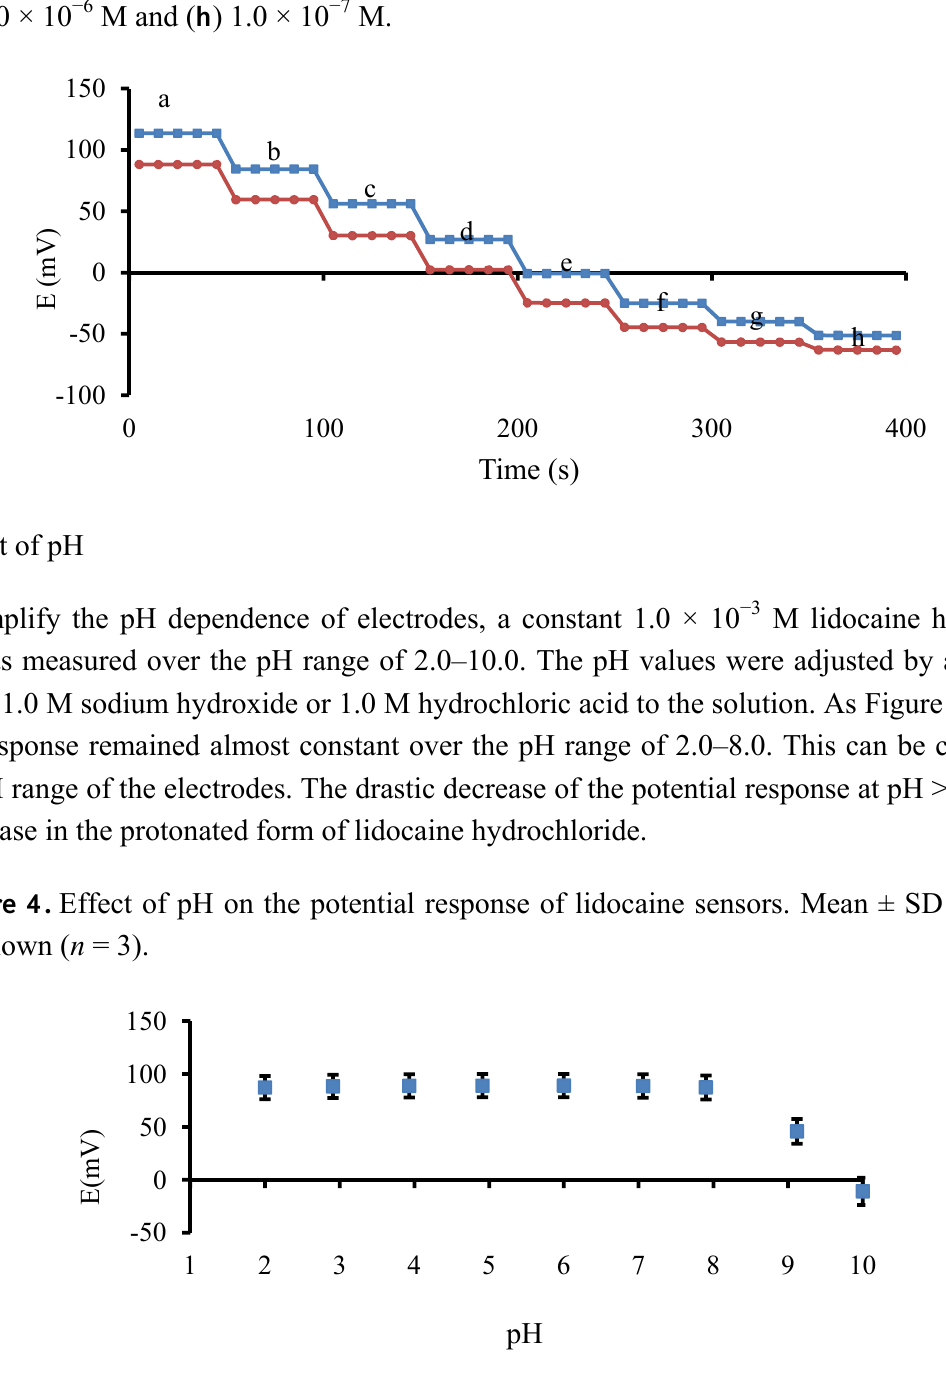
Figure 3. Dynamic response times of the electrodes for step change in concentration of propranolol hydrochloride ( ■ ) and lidocaine hydrochloride ( ● ). ( a ) 1.0 × 10 − 3 M; ( b ) 1.0 × 10 − 3.5 M; ( c ) 1.0 × 10 − 4 M; ( d ) 1.0 × 10 − 4.5 M; ( e ) 1.0 × 10 − 5 M; ( f ) 1.0 × 10 − 5.5 M;